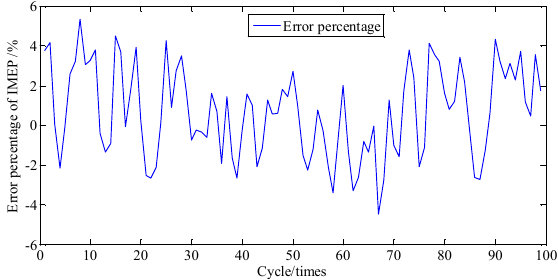
Figure 12. Error percentage of IMEP at A/F ratio 0.85 per cycle.